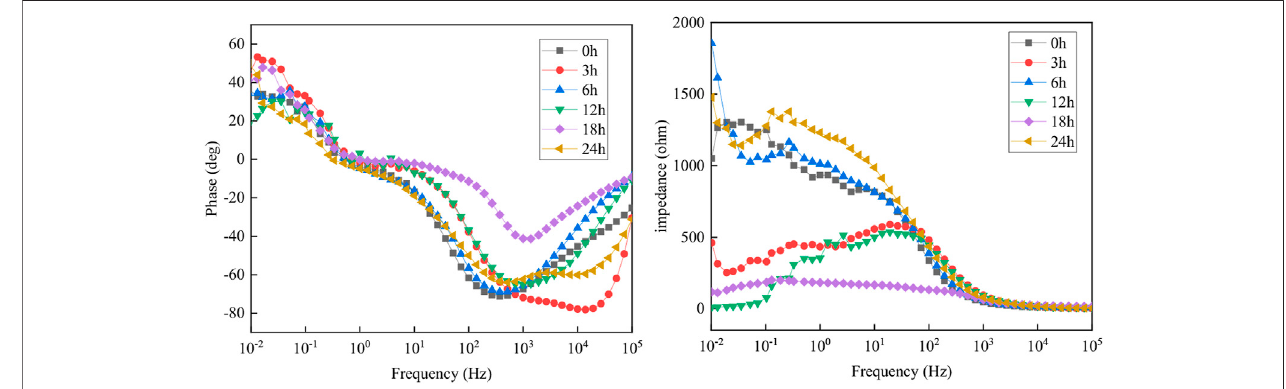
FIGURE 8 | EIS results of specimens after different immersion time.